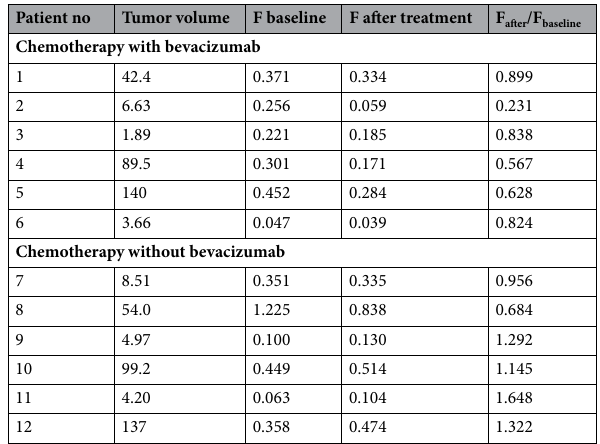
Table 2. Quantitative tumor blood flow values in each patient. F after /F baseline is the ratio of tumor blood flow after treatment to tumor blood flow at baseline. Tumor volume (cm 3 ), F: tumour blood flow (mL/cm 3 /min).